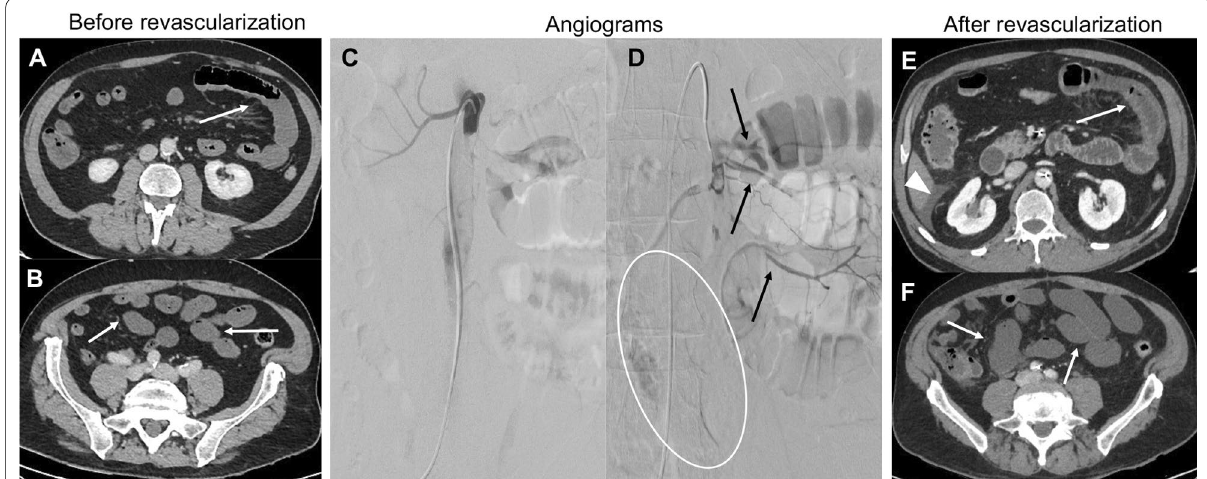
Fig. 3. A 61-year-old male patient presenting with early acute mesenteric ischemia. The contrast-enhanced CT (portal venous phase) showed a decreased enhancement of the proximal jejunum ( a ) and ileum ( b ) wall. Digital subtraction angiography showed complete occlusion of the superior mesenteric artery (SMA) ( c ). Partial revascularization of the proximal jejunum arteries was achieved after 12 h of in situ thrombolysis with no opacification of the distal SMA (white oval) ( d ). Unfortunately, the patient experienced further clinical deterioration. Contrast-enhanced CT showed thickening of the jejunum wall with fat stranding (arrow) consistent with reperfusion injury following the recanalization of the jejunal arteries ( e ). Peri-hepatic fluid (arrowhead) was also noted. Additionally, CT showed a dilated jejunum with a persistent absence of wall enhancement, suggesting transmural necrosis of non-revascularized segments ( f ). The patient underwent a laparotomy that confirmed the absence of necrosis of the jejunum. He underwent subsequent resection of 225 cm of the small bowel and suffered from short bowel syndrome